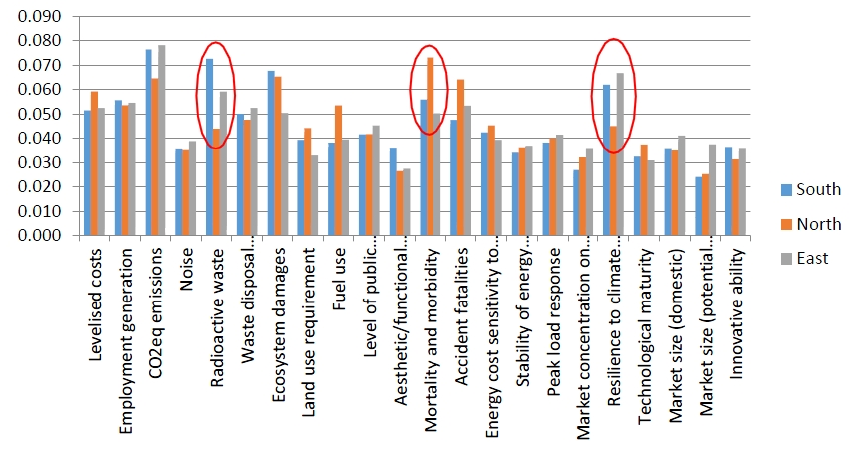
Figure 5. Average values of LGs’ priorities from different geographical European